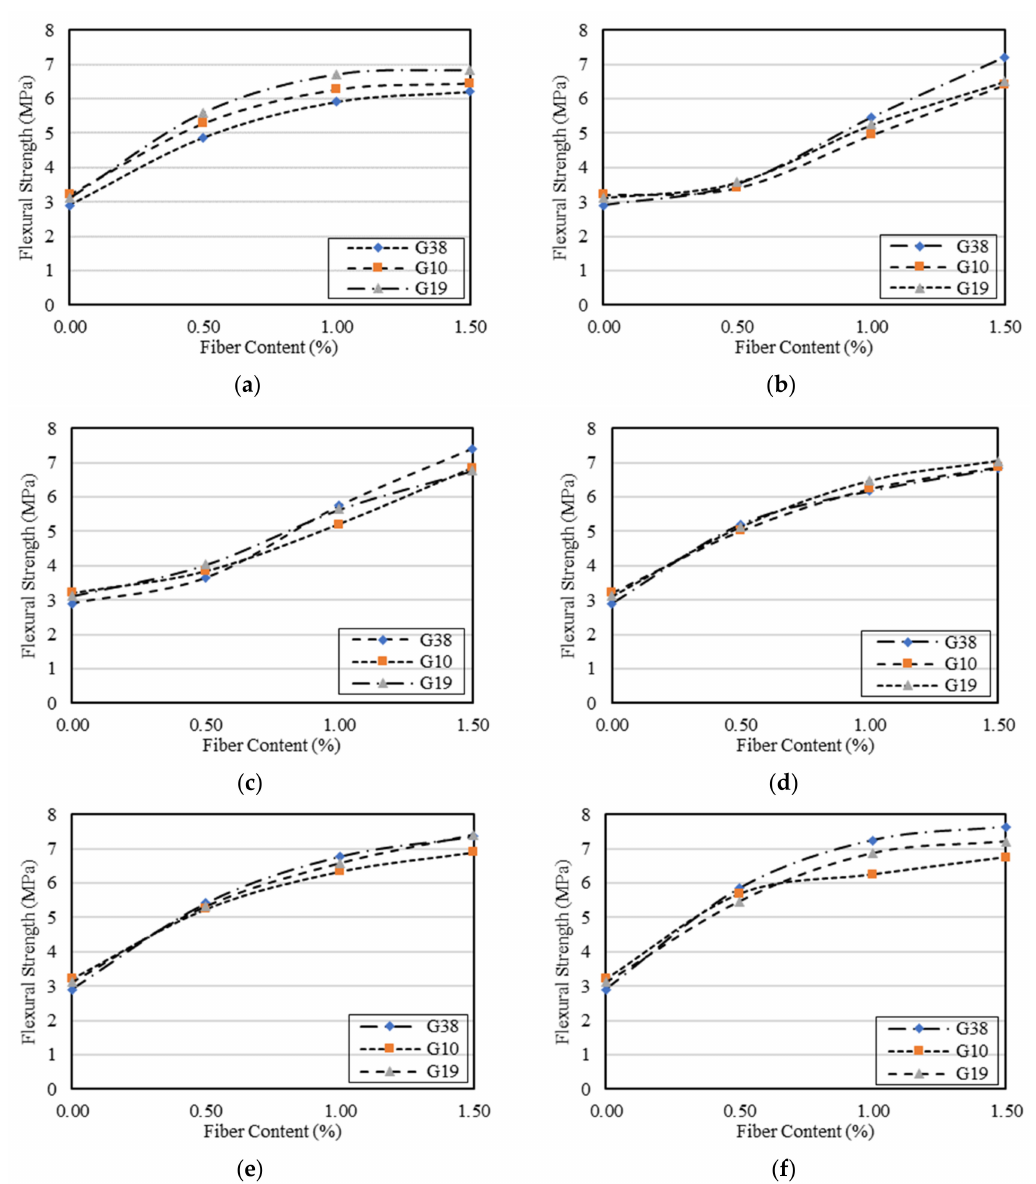
Figure 7. Effects of fiber type, dosage, and CAMZ on the flexural strength of ( a ) MSF-13, ( b ) HSF-35, ( c ) HSF-60, ( d ) SYF-19, ( e ) SYF-38, and ( f ) SYF-54